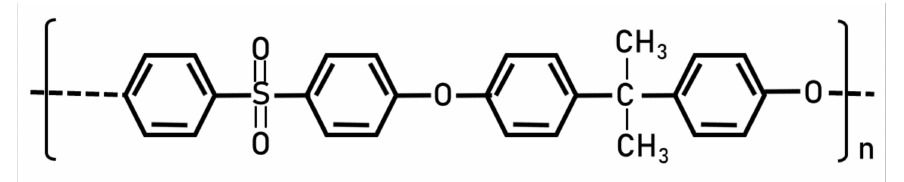
Figure 10. Structure of